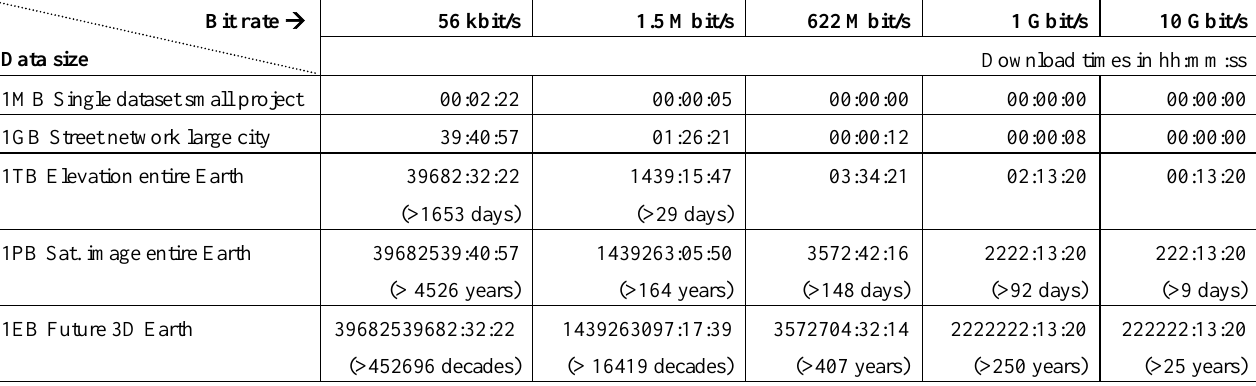
Table 1. Values are calculated without overhead [24]. Overhead depends on the application and can be as much as 50% (e.g., adds approximately 20 hours more waiting time for a 1 G street network on a 56 kbit/s connection or another 2h with a 622 Mbit/s connection). The data sizes are in measured in mega (MB), giga (GB), tera (TB), peta (PB) and exabytes (EB). We include a conversion of the hh:mm:ss format to a more ―readable‖ format to help the reader to interpret the values more